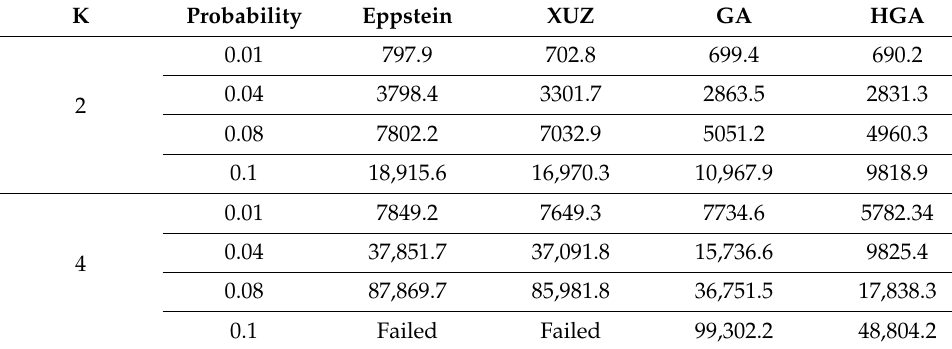
Table 3. Memory consumption of counterexample